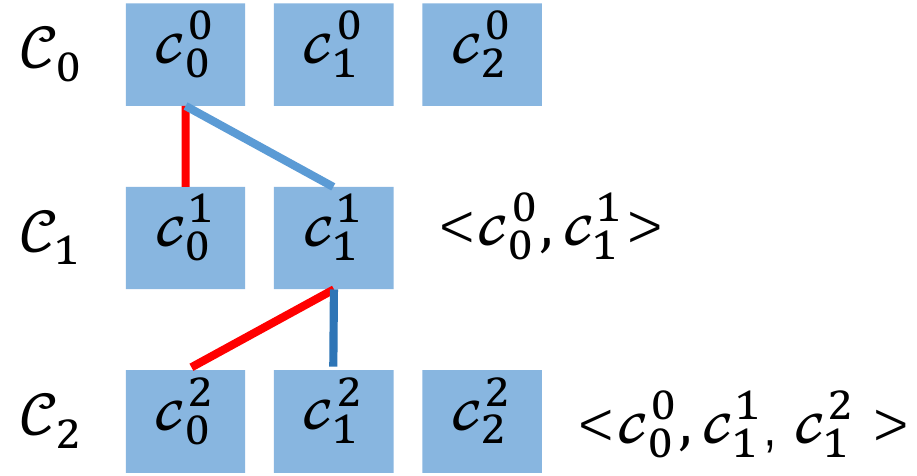
Figure 7. Example of restoring LP with depth-first method. The four bits on the left of c 0 and c 1 come from different IP addresses. Then, test c 0 0 of c 0 are the same as the four bits on the right side of c 1 0 tuple. Then, find the RE index from C 2, which comes from the same IP address with c 1 C 2, the four bits on the right side of c 2 the four bits on the left side of c 2 cannot form a candidate RE tuple with c 0 right side the same as the four bits on the left side of c 1